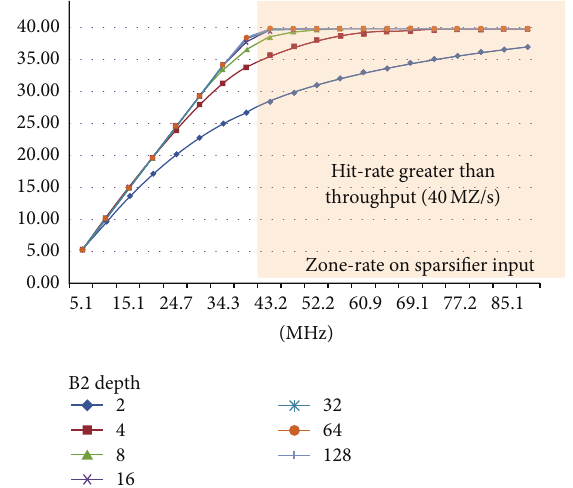
Figure 20: Barrel depth simulations: input versus output rates.